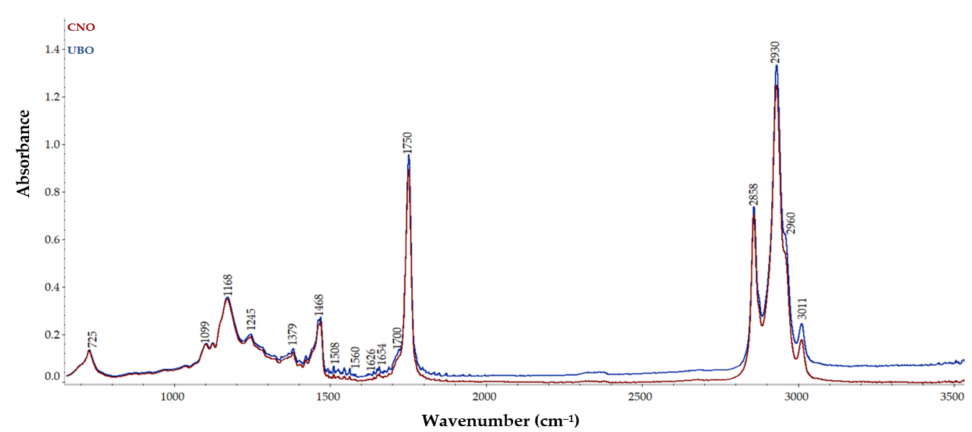
Figure 1. FT-IR spectra of U. barbata extract in canola oil (UBO) and canola oil